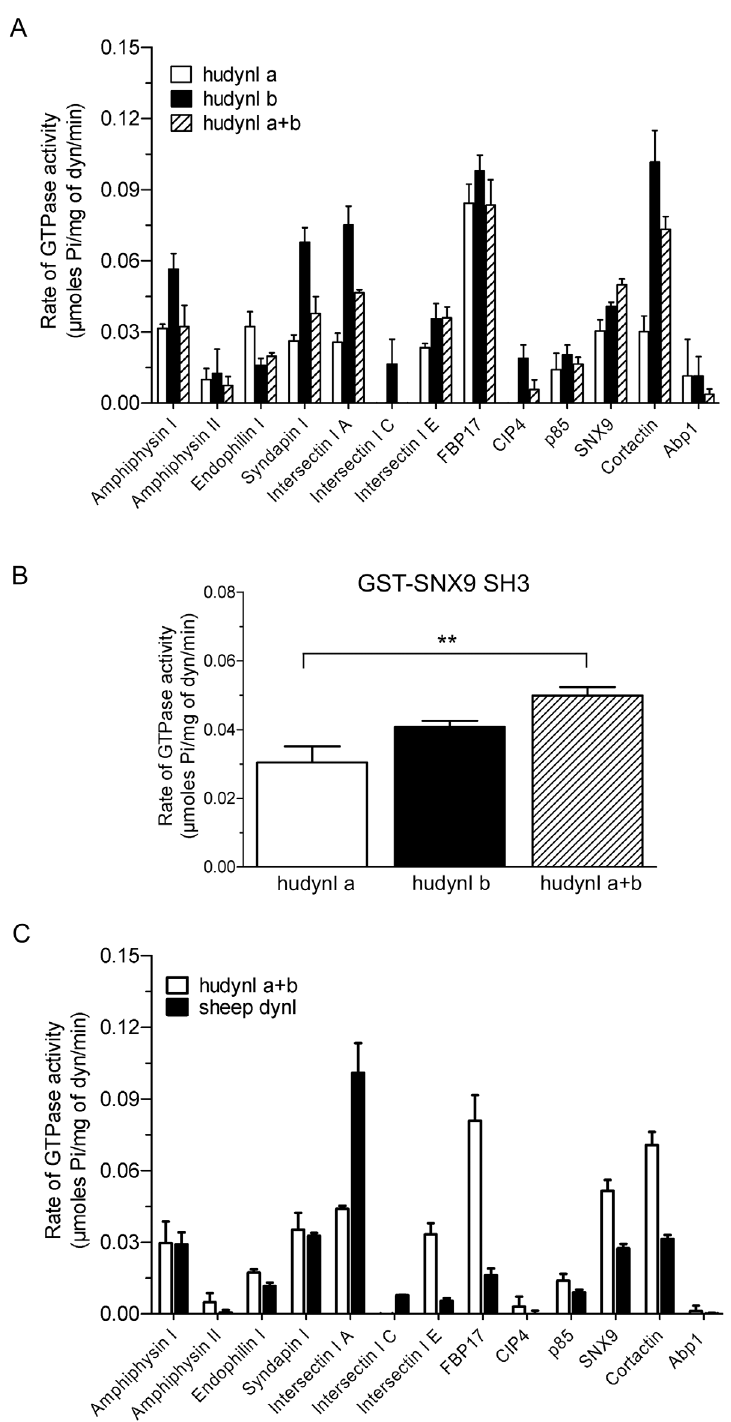
Fig 4. Comparison of the ability of 13 GST-SH3 domains to stimulate the rate of a mix of middle domain splice variants. (A) The effect of GST-SH3 domains (40 μ g/ml) on the GTPase rate of human dynamin Iab+bb (hudynI a+b) splice variants, which were mixed together at an equal molar ratio to a final concentration of 100 nM / 10 μ g/ml. These results are compared to the effect of GST-SH3 domains on the GTPase rate of individual Iab or Ibb splice variants in the presence of low salt (30 mM NaCl) (from Fig 2A). All data is shown as mean ± S.E.M. and n = 3. (B) Statistical analysis by one-way ANOVA followed